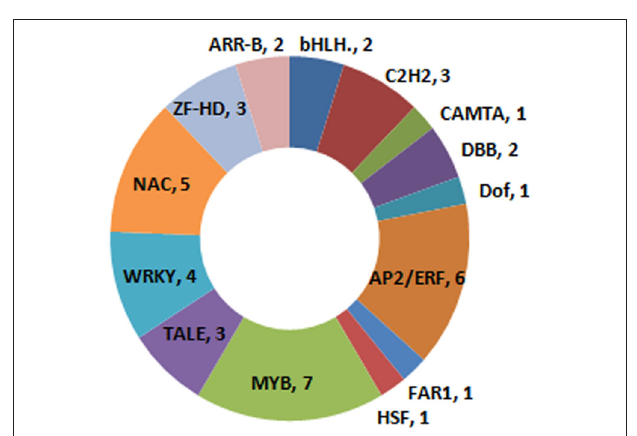
ortholog expression after 1 h of treatment ( Figures 6A,B ), though these expression levels dropped as time went on.